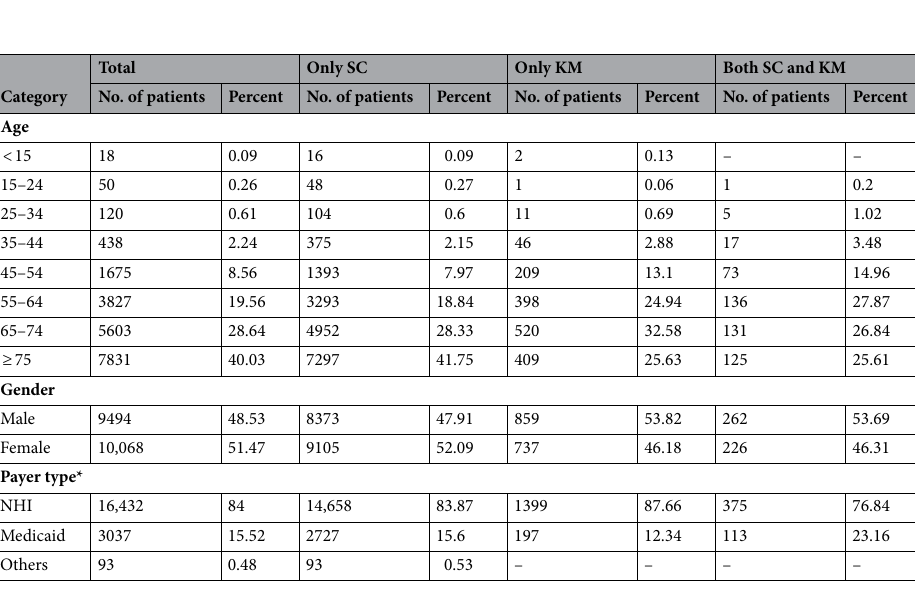
Table 1. Basic characteristics of